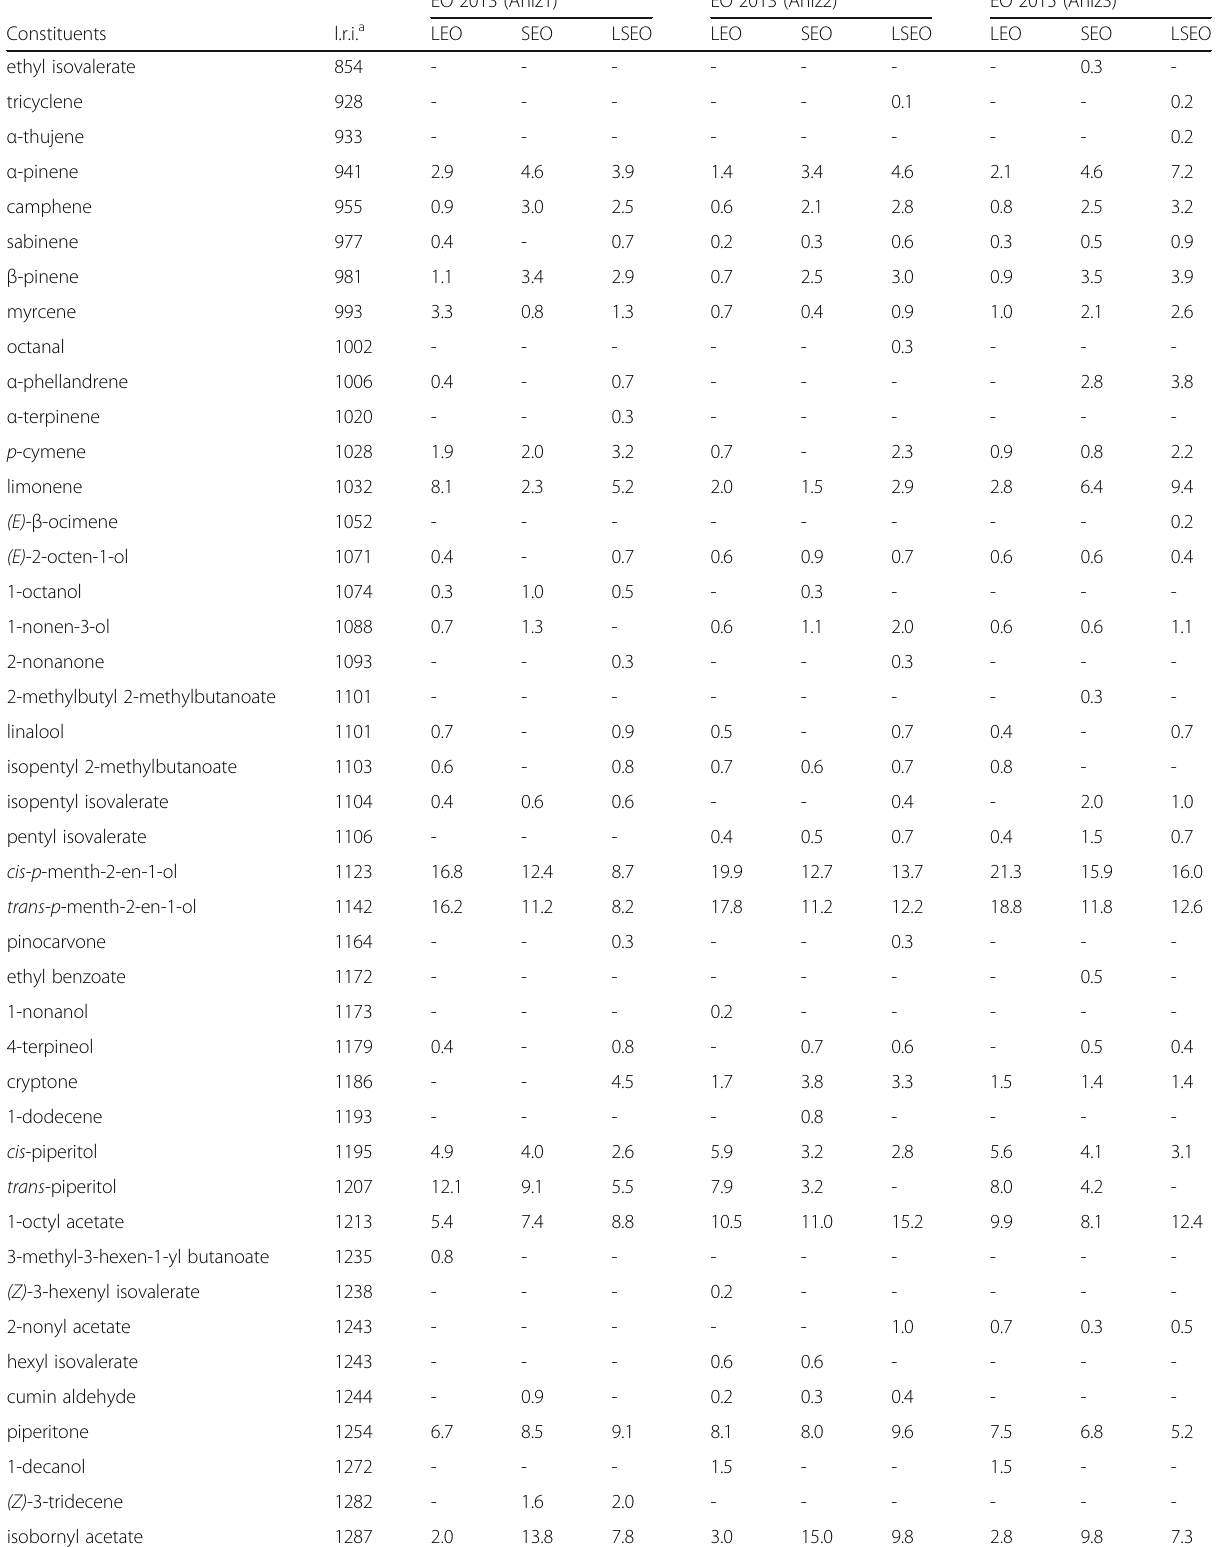
Table 1 Chemical composition of the essential oil of Haplophyllum tuberculatum vegetal parts